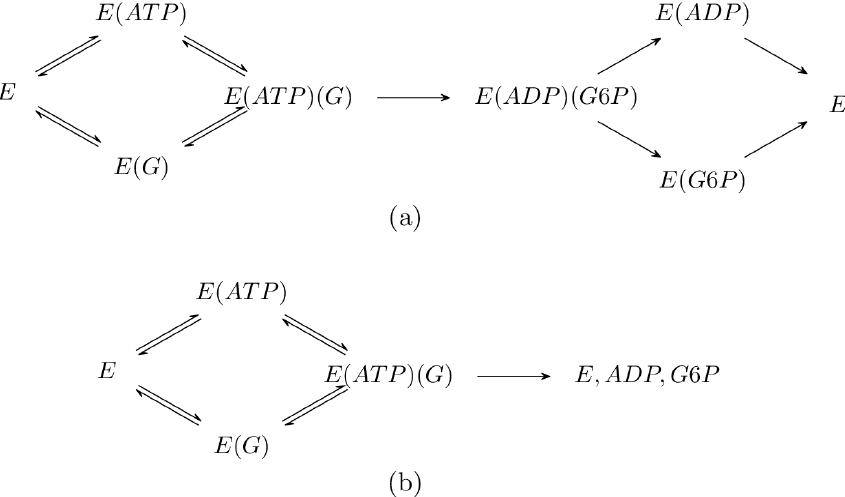
Figure 4. The Bi Bi mechanism for glucose phosphorylation. ( a ) The full Bi Bi mechanism for the phosphorylation of glucose. ( b ) The simplified Bi Bi mechanism modelled in the current study.